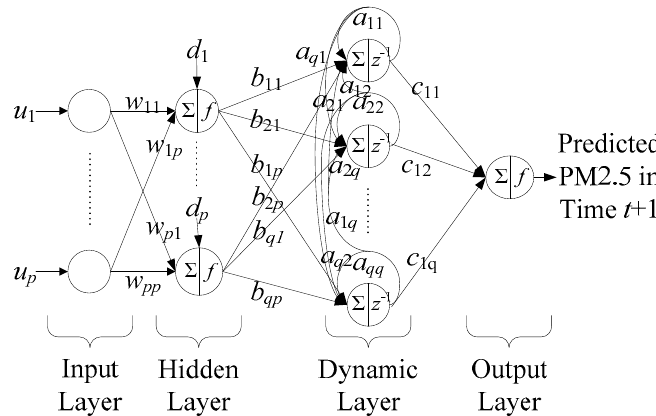
Figure 9. Framework of Hammerstein recurrent neural network (HRNN), which includes an input layer, hidden layer, dynamic layer, and output layer.